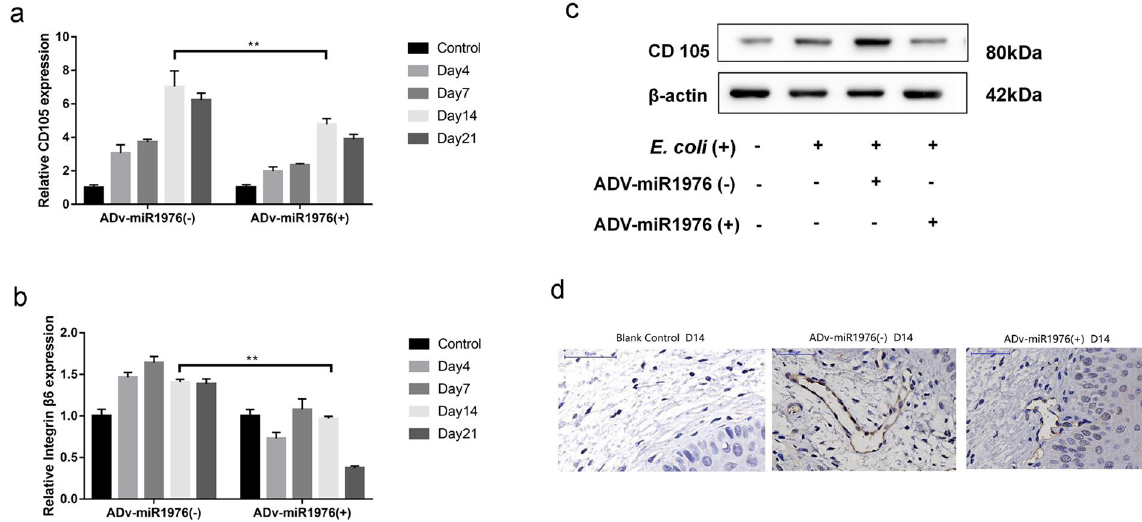
Figure 4. MiR1976 overexpression attenuated the alterations in CD105 and integrin α v β 6 expression. ( a ) Transfection of the miR1976 overexpression vector ameliorated the E. coli infection-induced increase in the mRNA expression level of CD105; ( b ) MiR1976 overexpression attenuated the E. coli infection-induced increase in the mRNA level of integrin α v β 6; ( c ) MiR1976 overexpression ameliorated the E. coli -induced alteration in CD105 expression. ( d ) MiR1976 overexpression attenuated the E. coli infection-induced increase in CD105 protein expression, as shown by immunohistochemical analysis. * P < 0.05, ** P < 0.01, compared with the control group; * P < 0.05, ** P < 0.01, compared with the E. coli infection